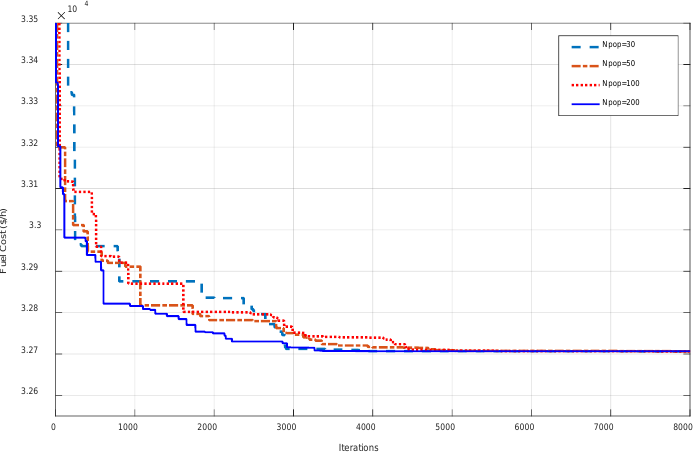
Figure 12. Convergence characteristics of MP-CJAYA with varying population sizes for case V.